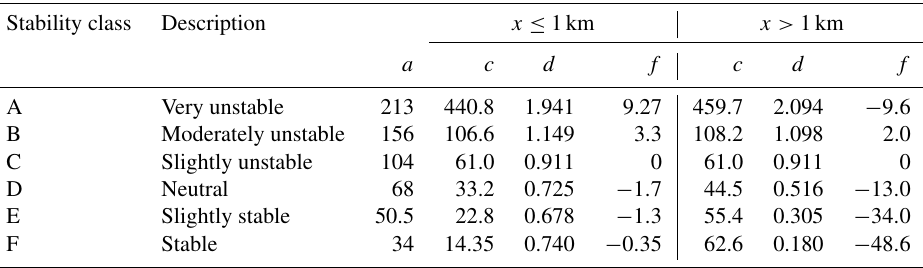
Table 3. Empirical stability parameters for the computation of the horizontal and vertical dispersion coefficients σ y , σ z (Martin, 1976) for the different atmospheric stability classes according to Pasquill (1961). For intermediate stability classes like A–B, averages of parameter values for A and B are